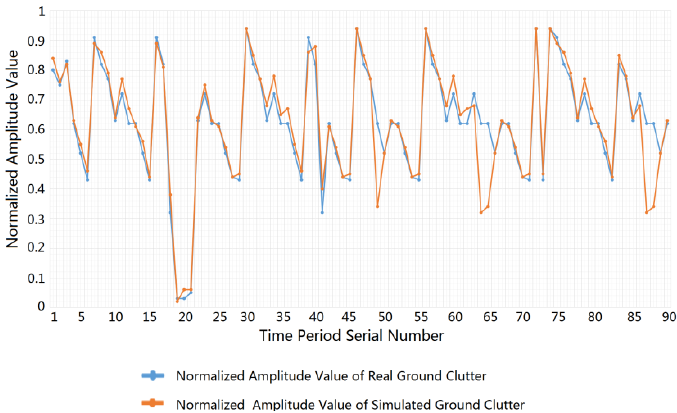
Figure 10. Comparison of amplitude values between actual clutter and simulated clutter.